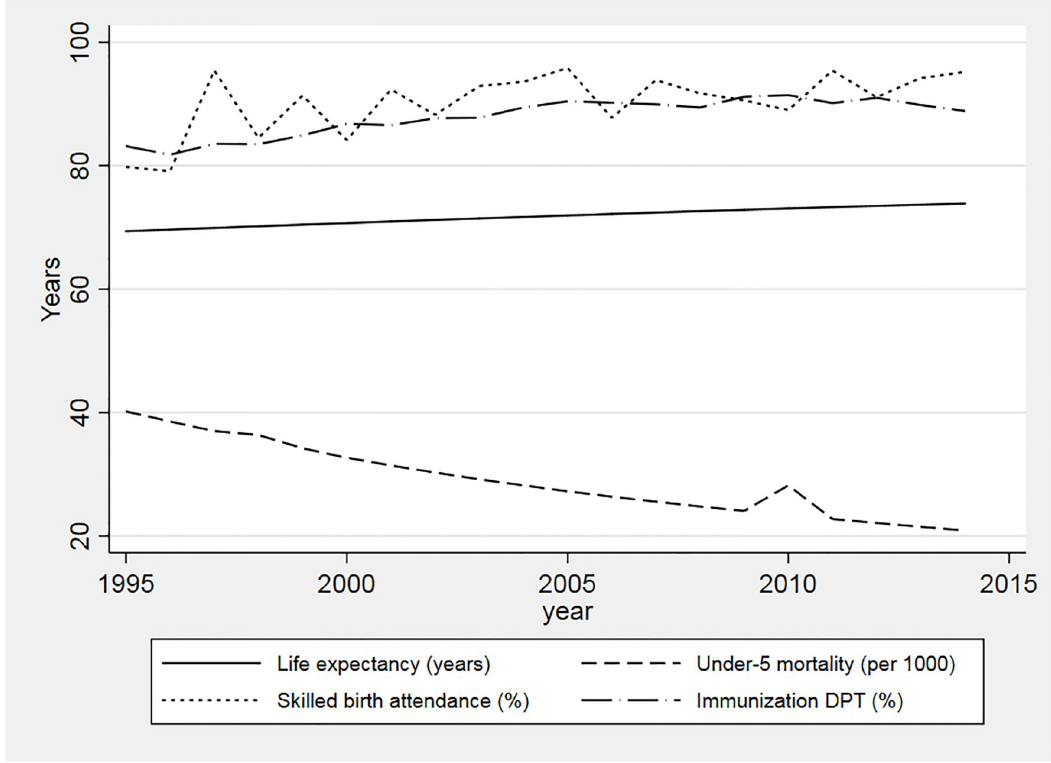
Fig 1. Selected health outcomes and coverage indicators in LAC